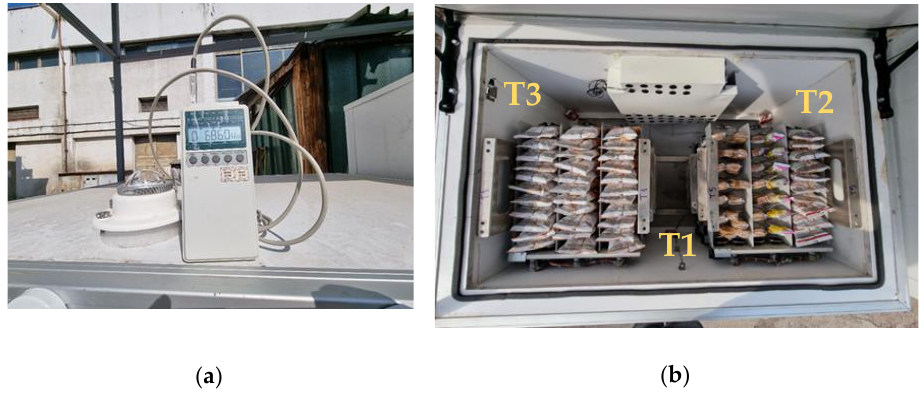
Figure 7. Monitoring sensors (T1, T2, T3 temperature sensors).